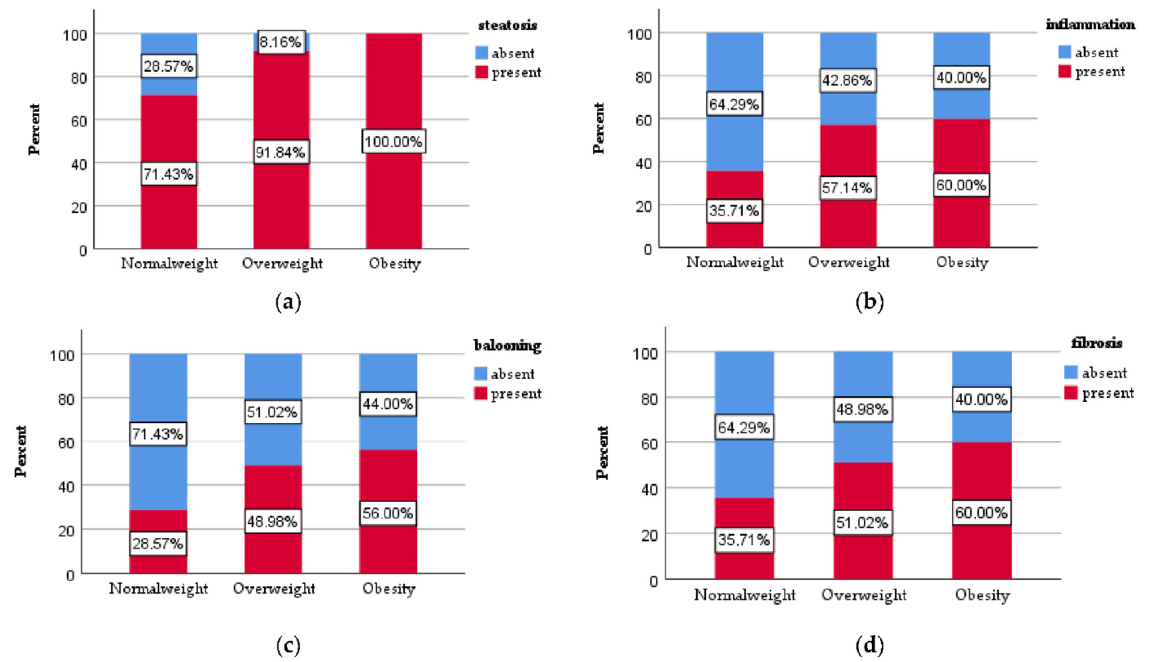
Figure 1. The distribution of ( a ) liver steatosis, ( b ) liver inflammation, ( c ) hepatocyte ballooning and ( d ) fibrosis in the study group.